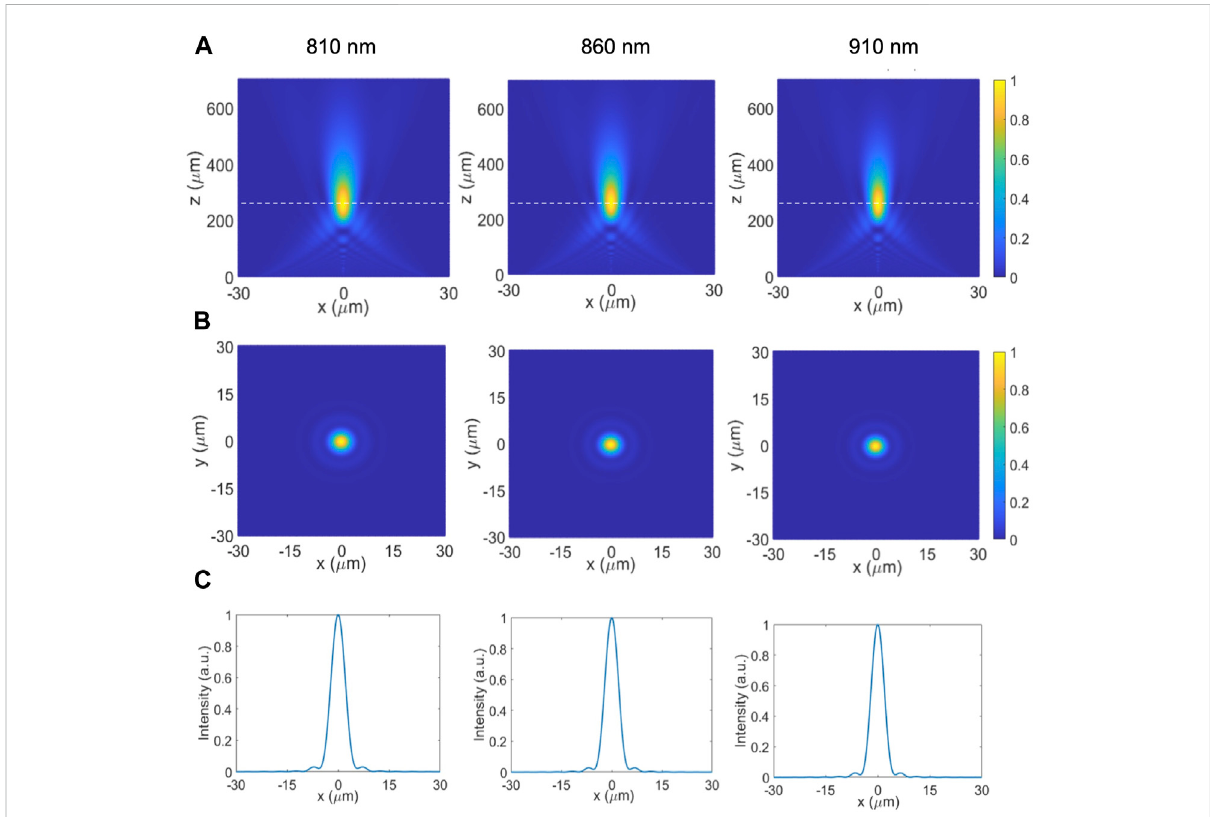
FIGURE 6 Simulationresultsfor810 – 910 nmachromaticon-axismetalens. (A) Normalizedintensityplotofthefocalpointpro fi leofachromaticmetalens inthex-zplaneat λ =810,860,and910 nm. (B) Normalizedintensityplotofthefocalpointpro fi leofachromaticmetalensinthex-yplaneat λ =810, 860, and 910 nm. (C) Normalized intensity plot of the focal point pro fi le of achromatic metalens along the x-axis at λ = 810, 860, and 910